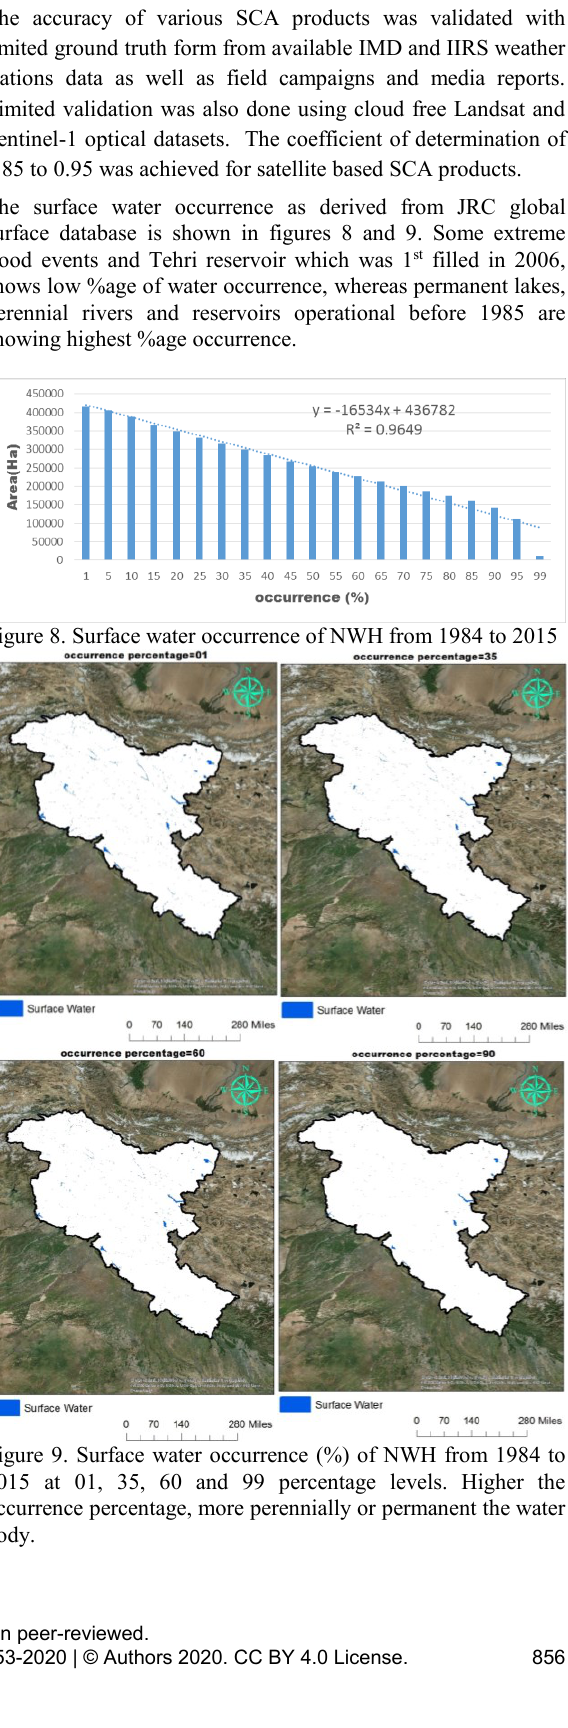
Figure 7. Snow cover area for Beas river basin as derived from